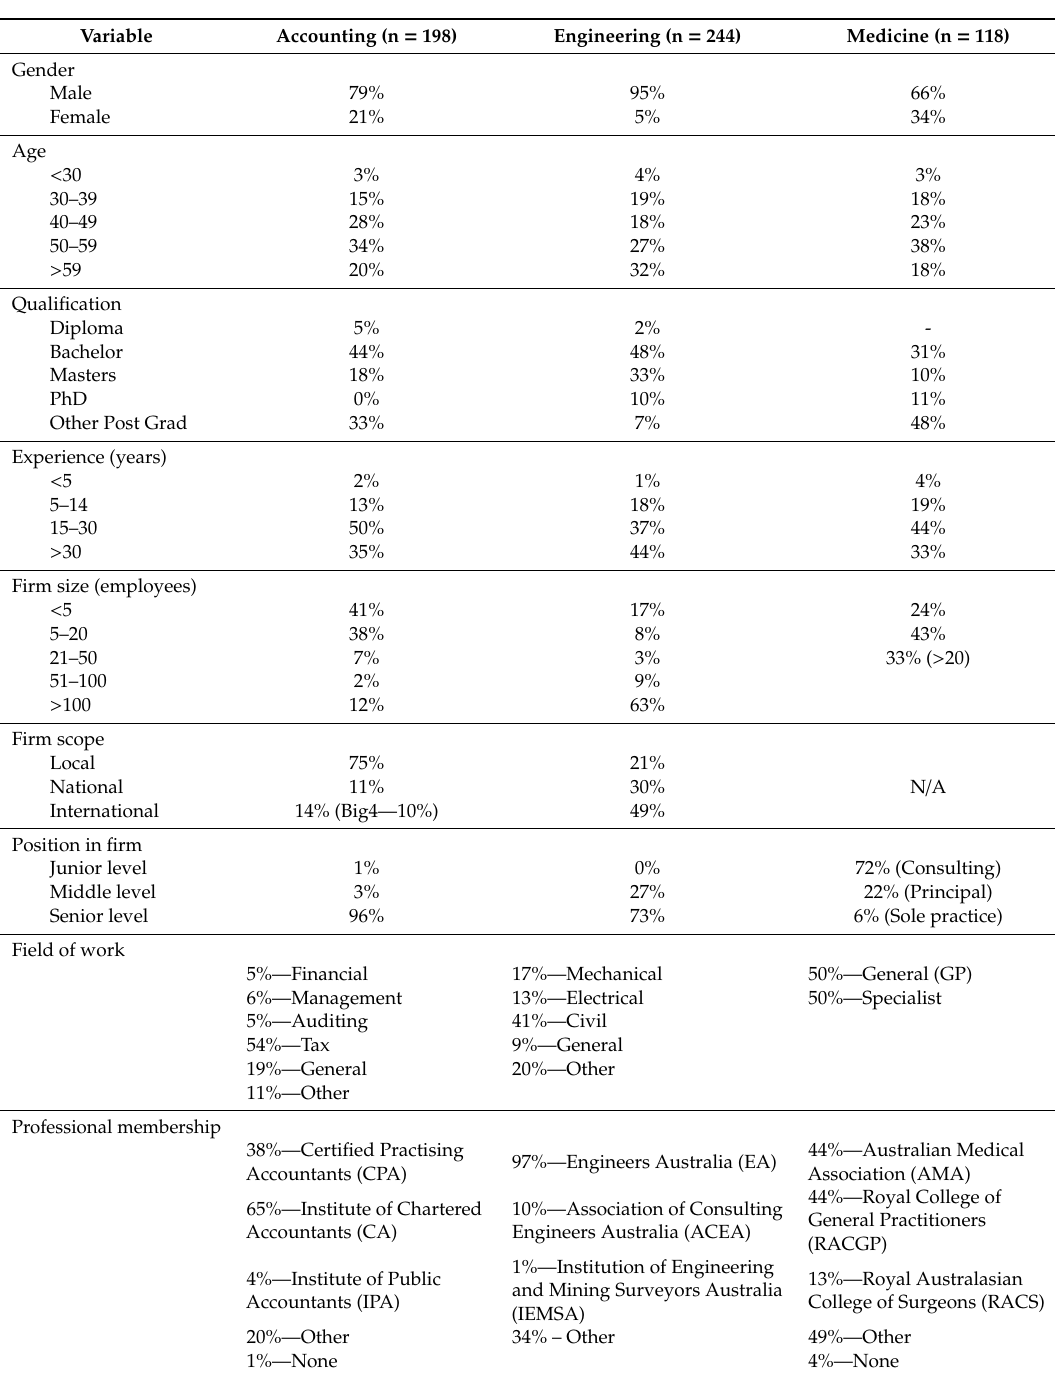
Table 3. Descriptive statistics of participants (n =